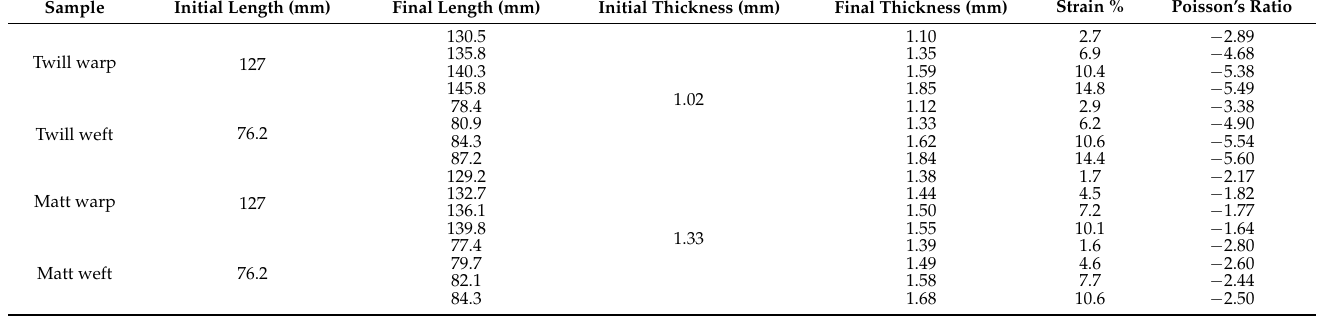
Table 4. Out-of-plane thicknesses with NPR and corresponding strain rates.